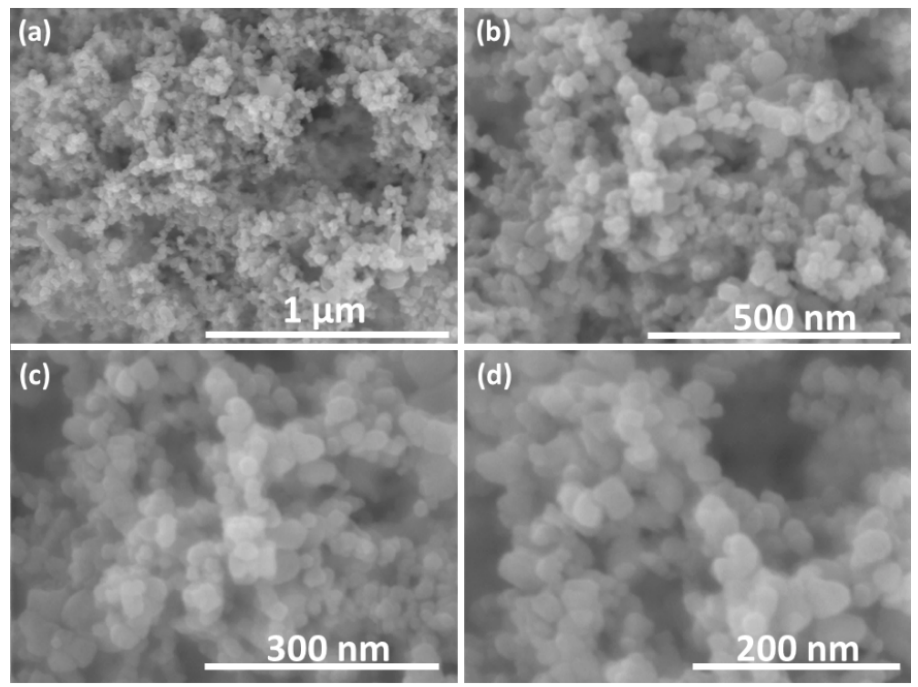
Figure 2. ( a ) and ( b ) Low magnification and ( c ) and ( d ) high magnification FESEM images for Fe-doped TiO 2 nanoparticles.